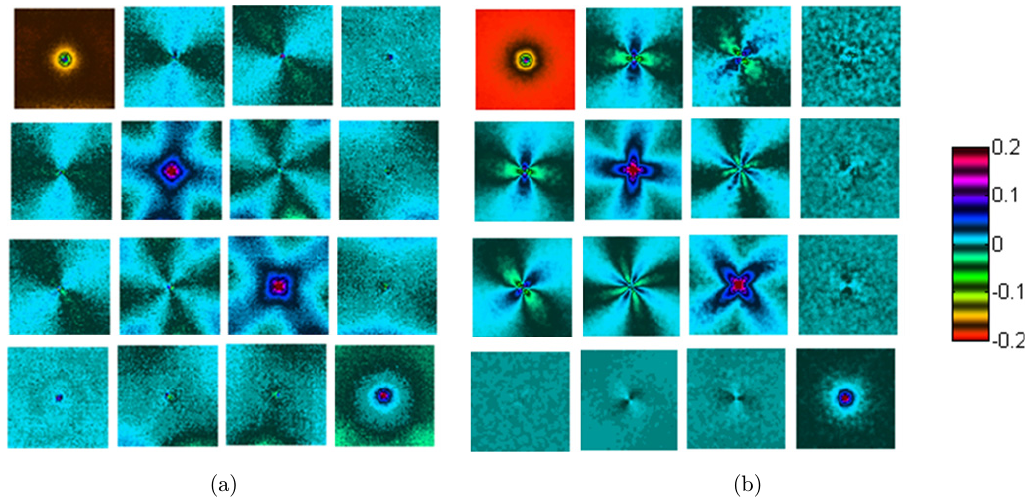
Fig. 5. Backscattering Mueller matrices for sphere optical active medium: (a) experimental result of microsphere sucrose solution and (b) Monte Carlo simulated